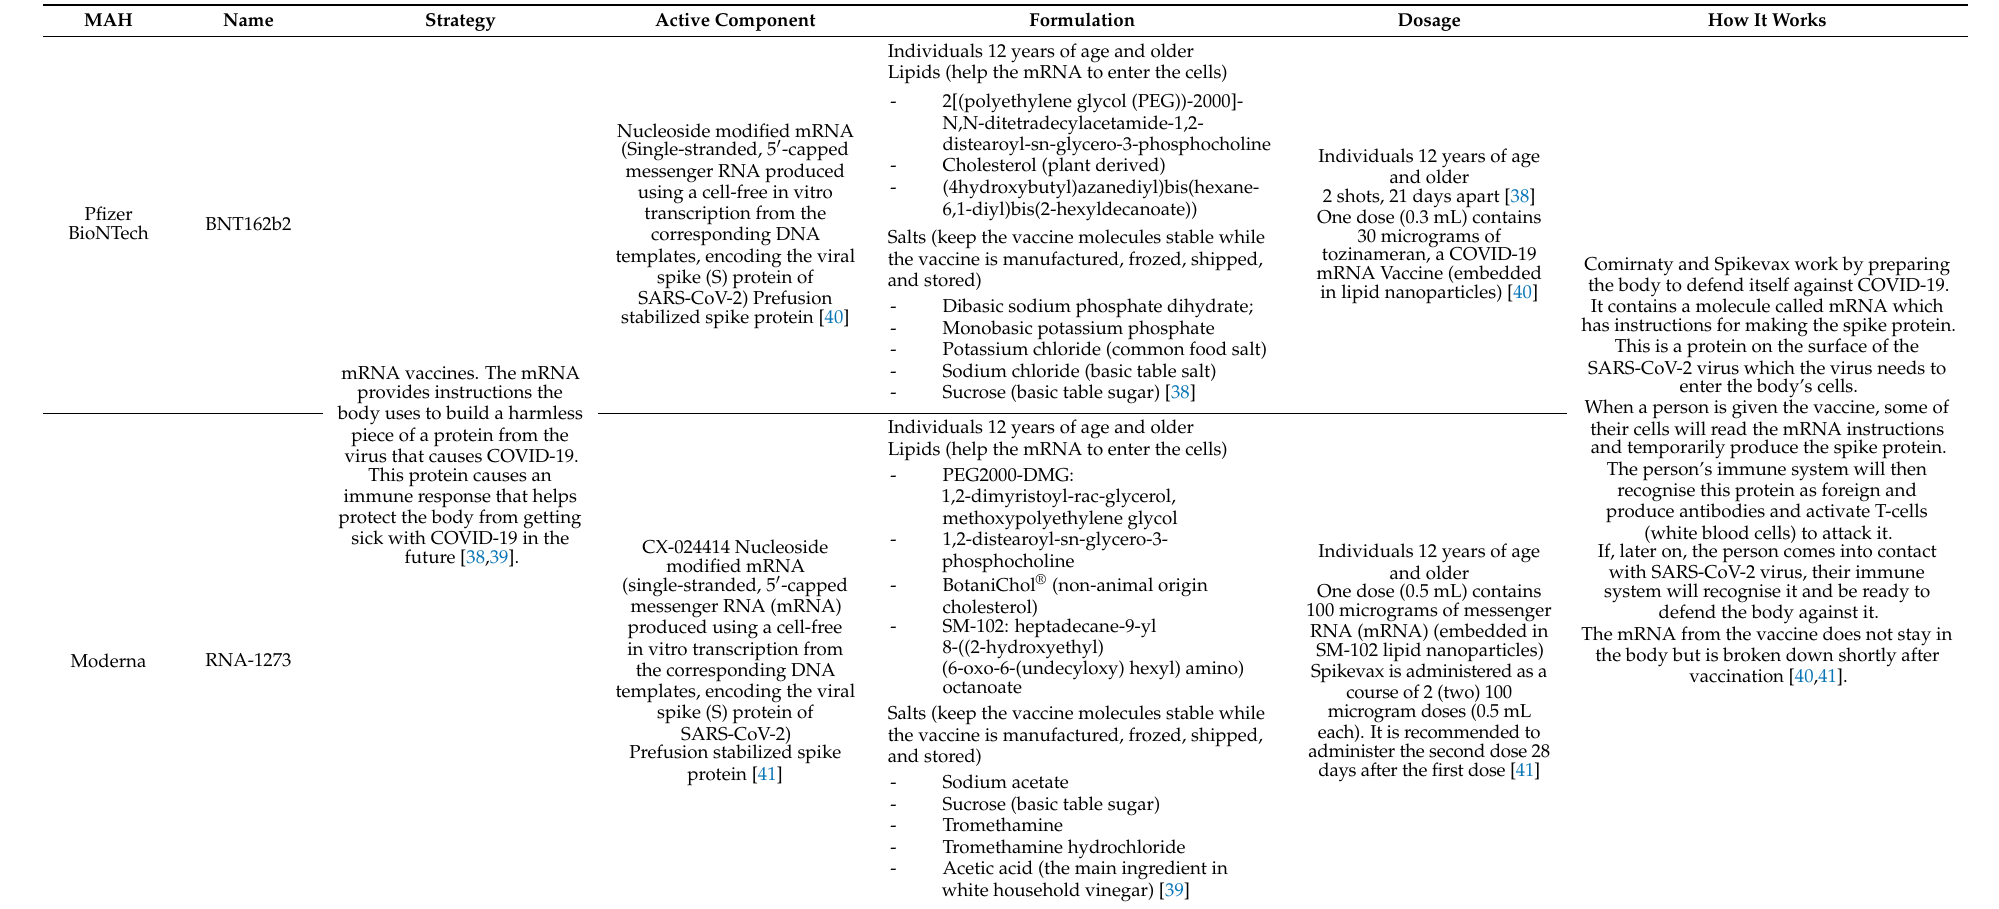
Table 1. Principal data for four vaccines to COVID-19 about indications and